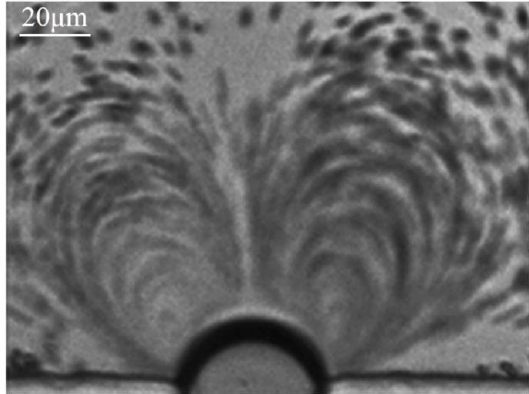
Figure 2. Optical field image of microstreaming generated by microbubble oscillation. When the PZT is excited, the 2 μm polystyrene particles around the microbubble is driven to follow the microstreaming.